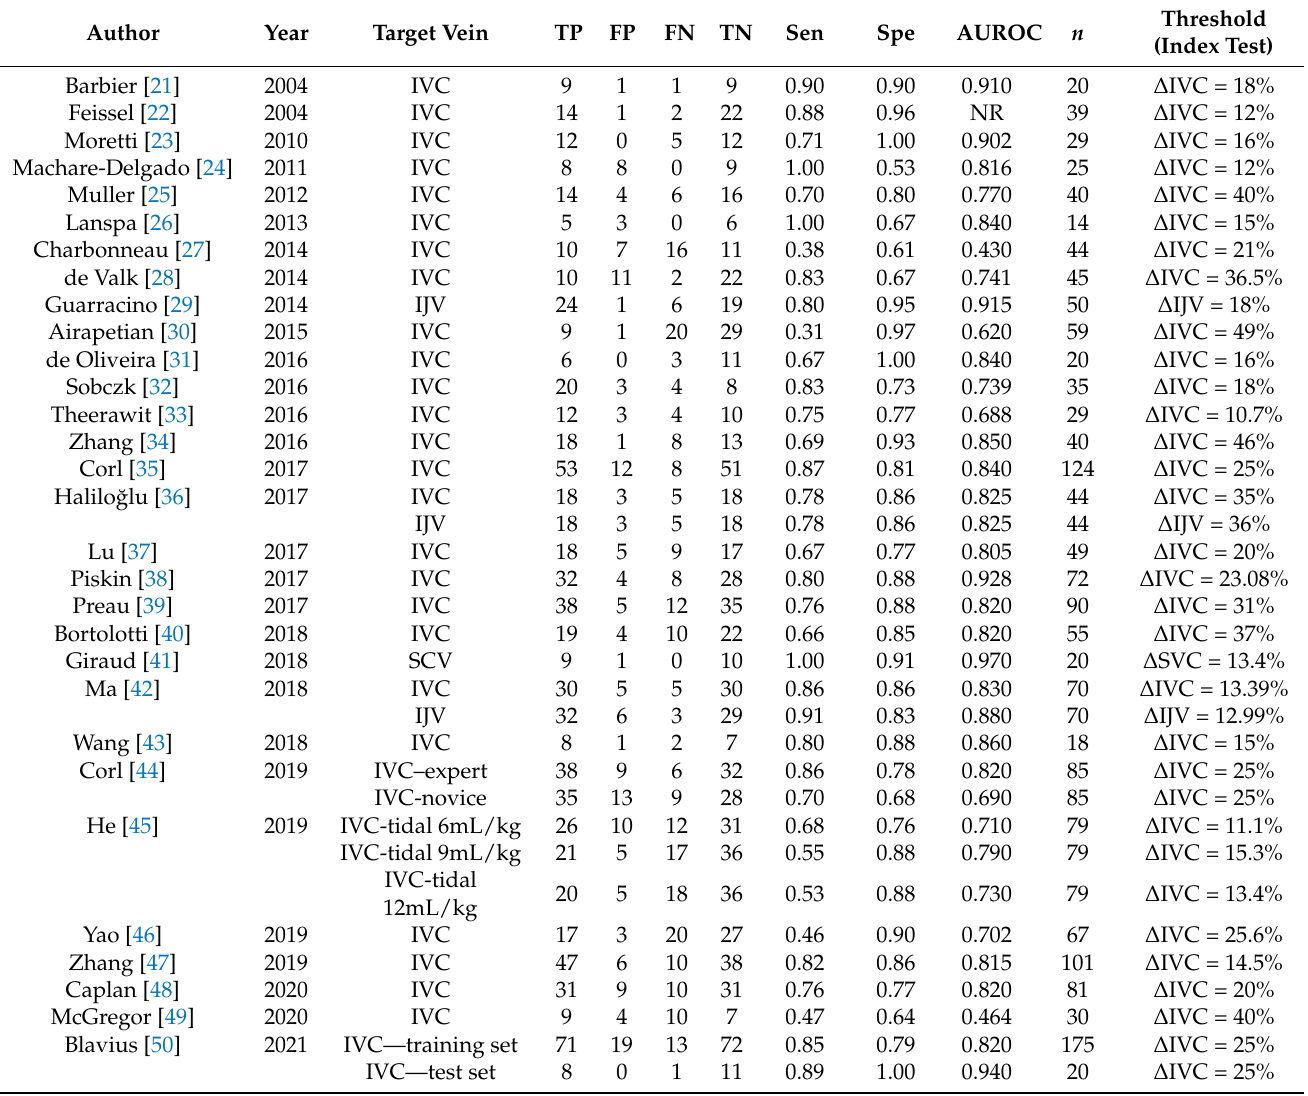
Table 2. Diagnostic test accuracy of eligible